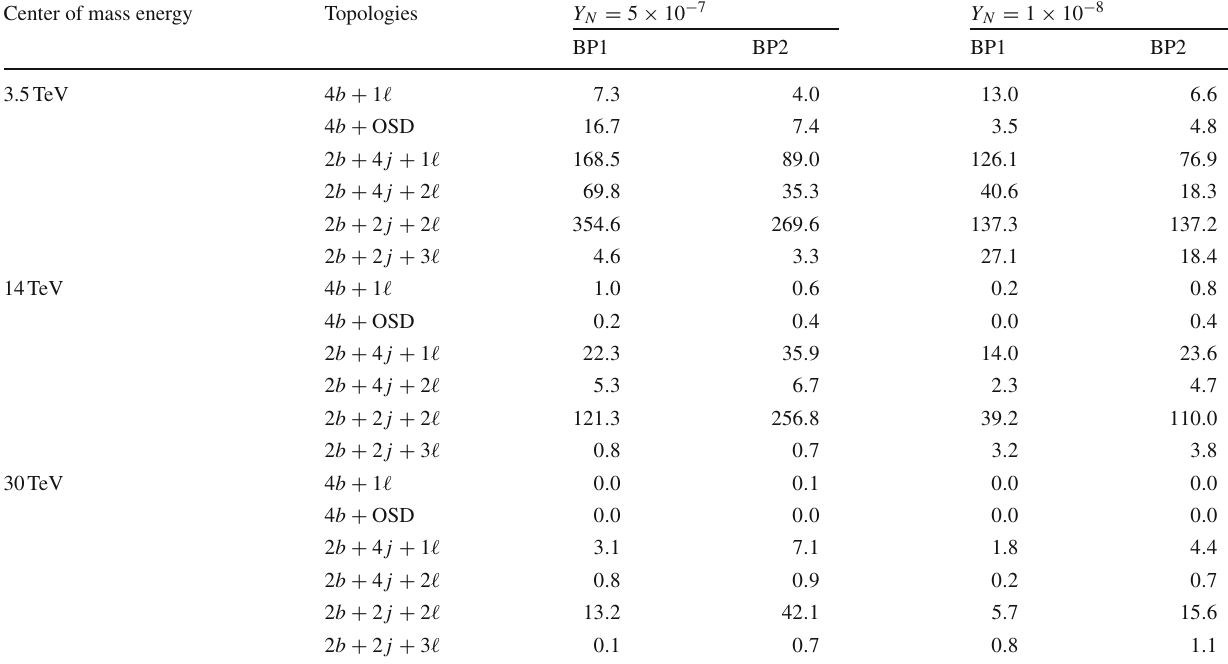
Table 15 Number of events for single Higgs boson and di-Higgs boson mass peaks after the window cuts around the peak of the invariant mass distributions for the benchmark points at the muon collider with the Topologies